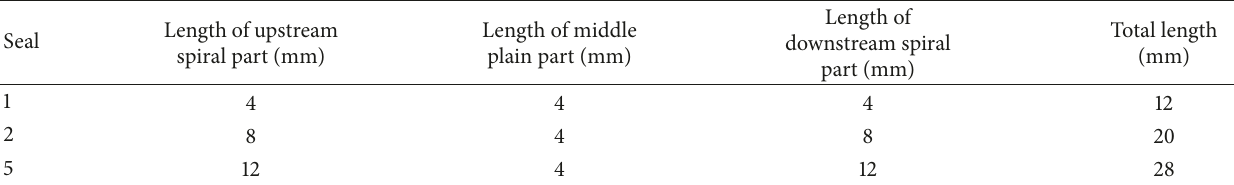
Figure 7: Comparisons between dynamic characteristics of herringbone-grooved TOR and TOS seals. Table 1: Configurations of the model